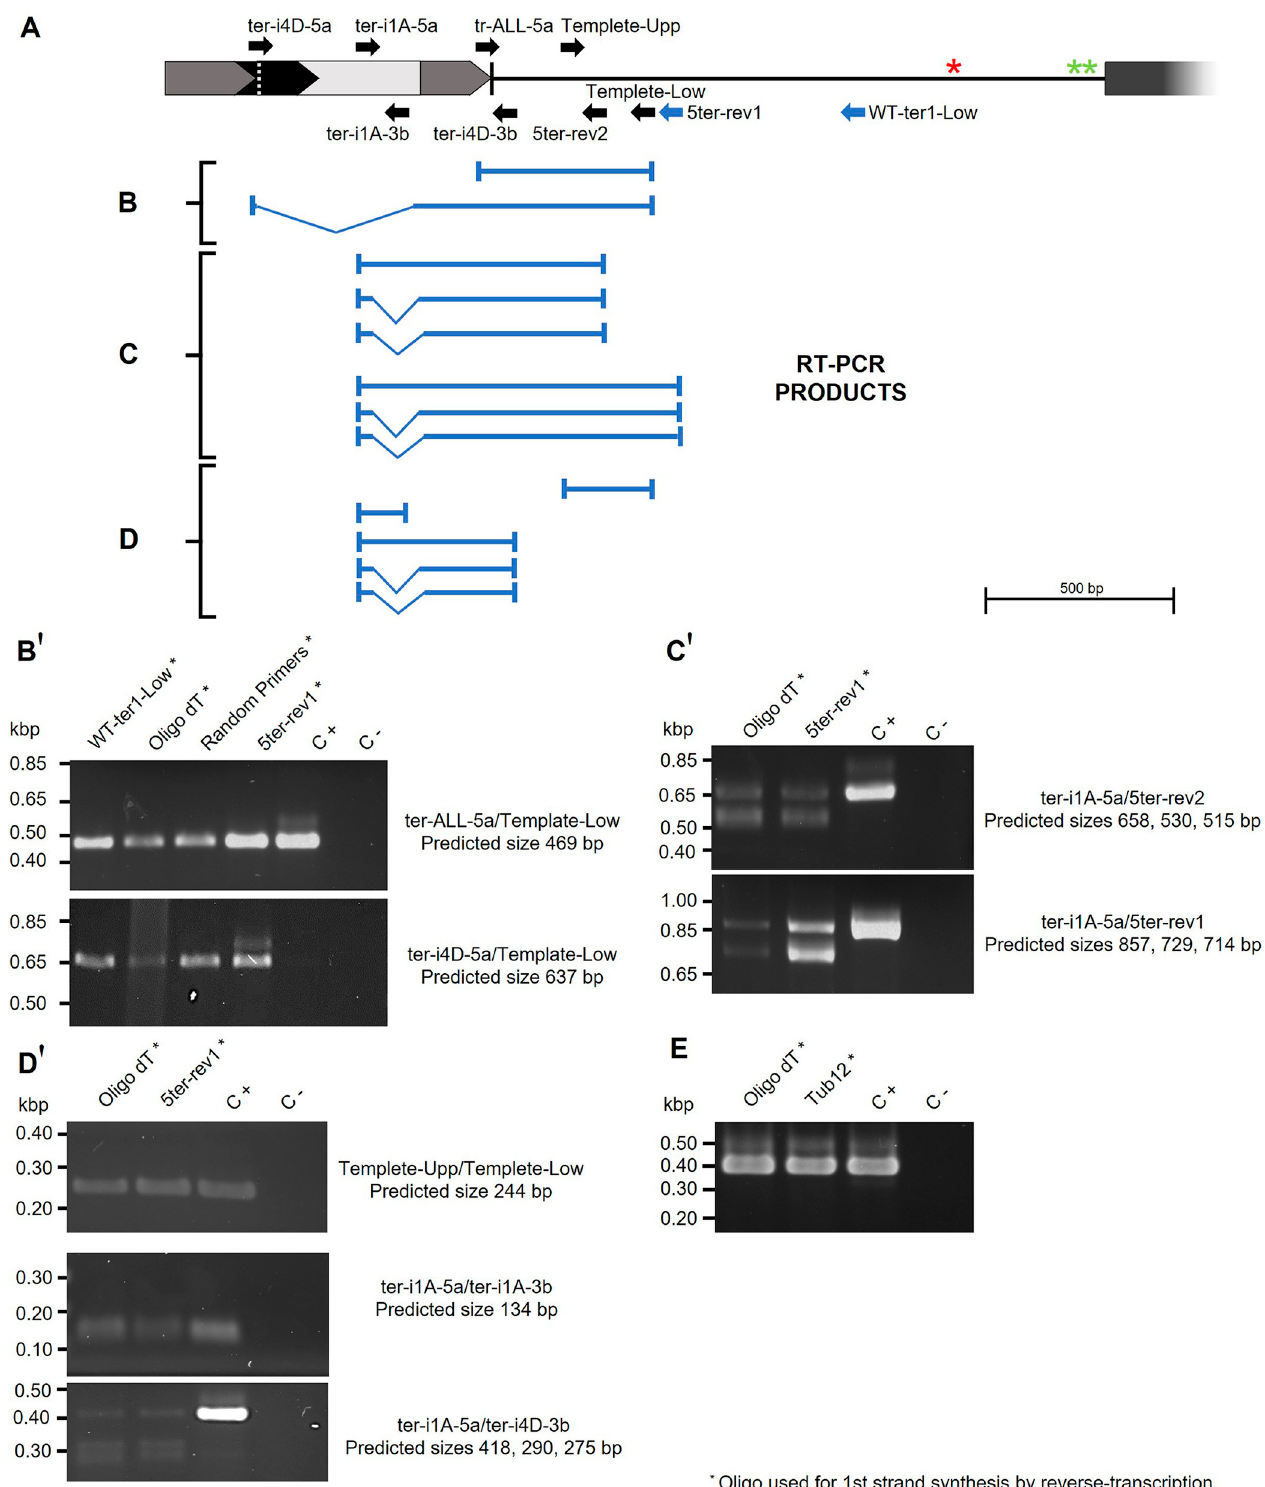
Fig 4. Confirmation of transcription from the ter1 locus occurs. (A) Upper panel. Schematic representation of ter1 locus and alignment sites of primers used for RT-PCR assays located upstream of the putative Sm site (red asterisk) and polyadenylation signals (green asterisks), reverse primers used for cDNA synthesis are represented by blue arrows. (B–D). Combination of primer pairs used and expected amplicon sizes for each combination. (B’–D’) Agarose gel